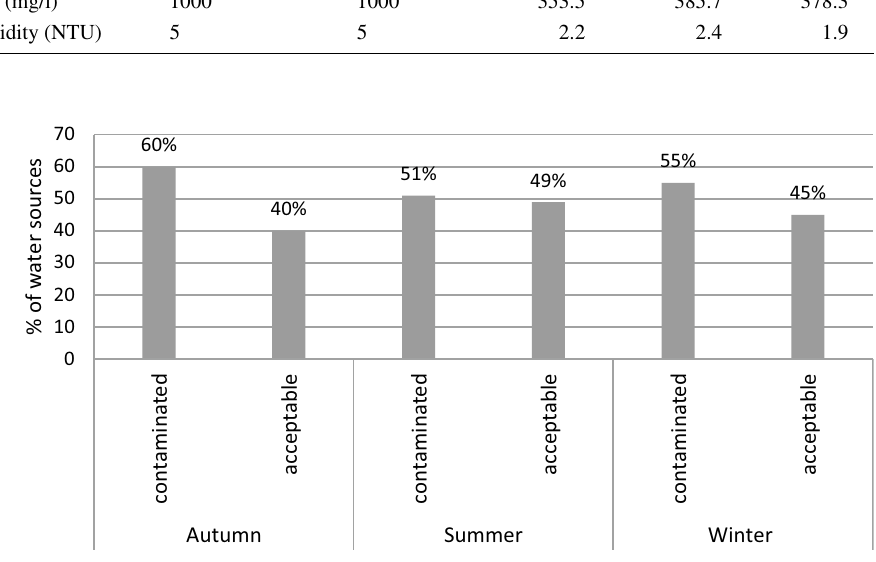
Table 4 Percent of seasonal E. coli in different water sources Water source